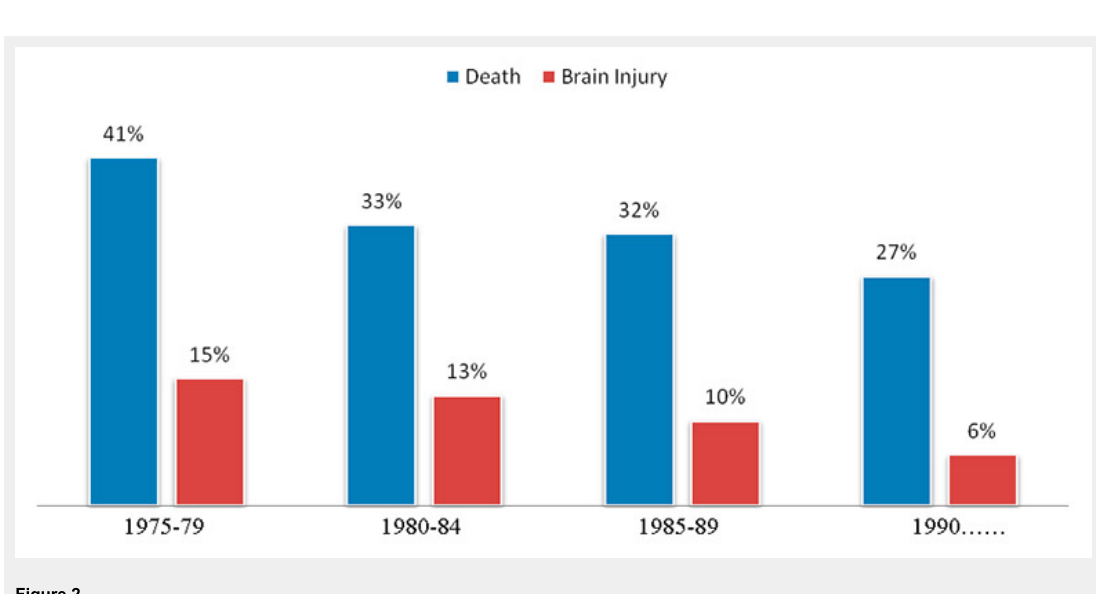
Figure 1 Historical evolution of improvements in anaesthesia-related mortality.